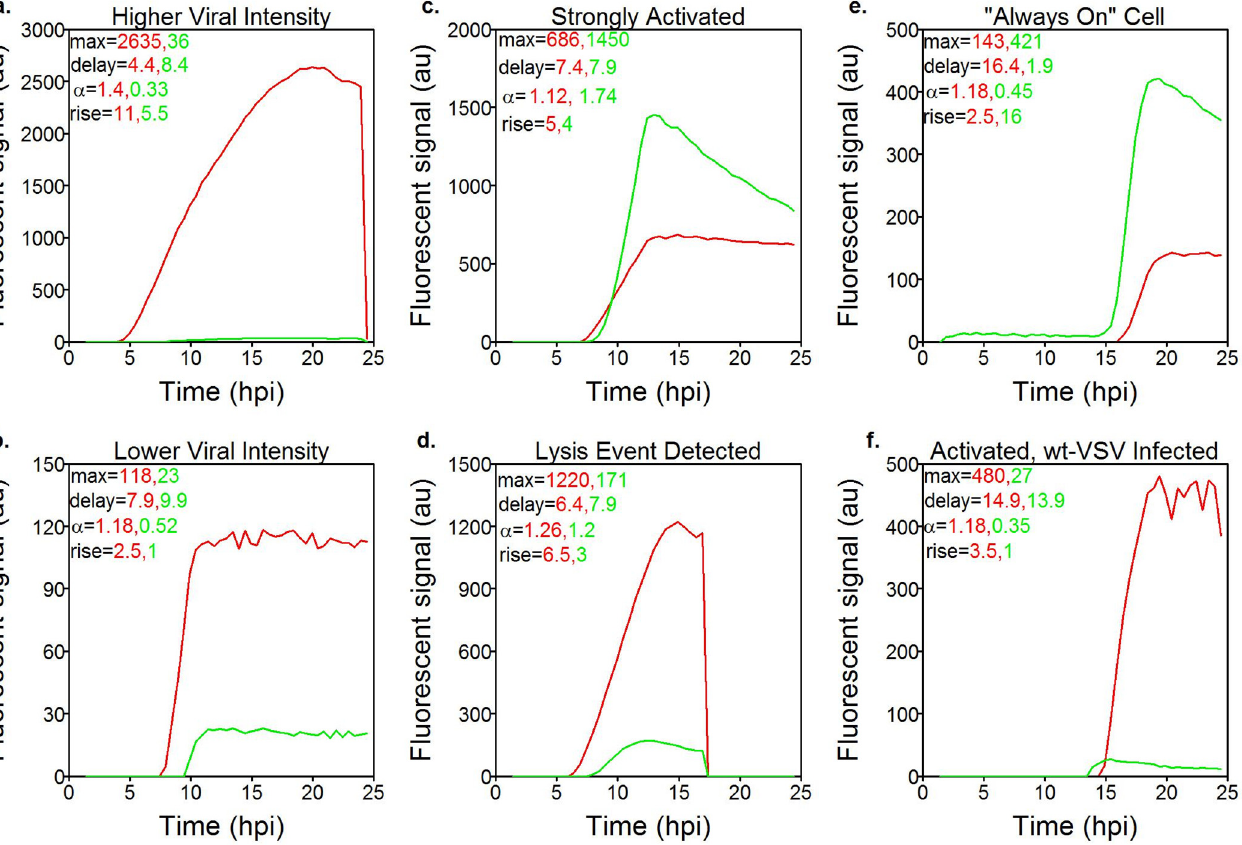
Fig 8. Sample VSV-rWT viral and innate immune reporter protein expression kinetics from six individual cells. Kinetic parameters have been extracted from the trajectories of both the viral (red) and host (green) trajectories and displayed in the top left corner of each figure. Maximum yields from individual cells vary greatly (a-b), host reporter expression can be greater or lesser than viral gene expression given similar starting conditions (c-d), and cells can lyse (d) or remain intact during imaging. Single-cell analysis can detect and quantify cells displaying rare behavior, such as those that appear to have a basal level of innate immune activation all the time (e) and cells infected with wt-VSV that express ZS-Green despite encoding a functional matrix gene.